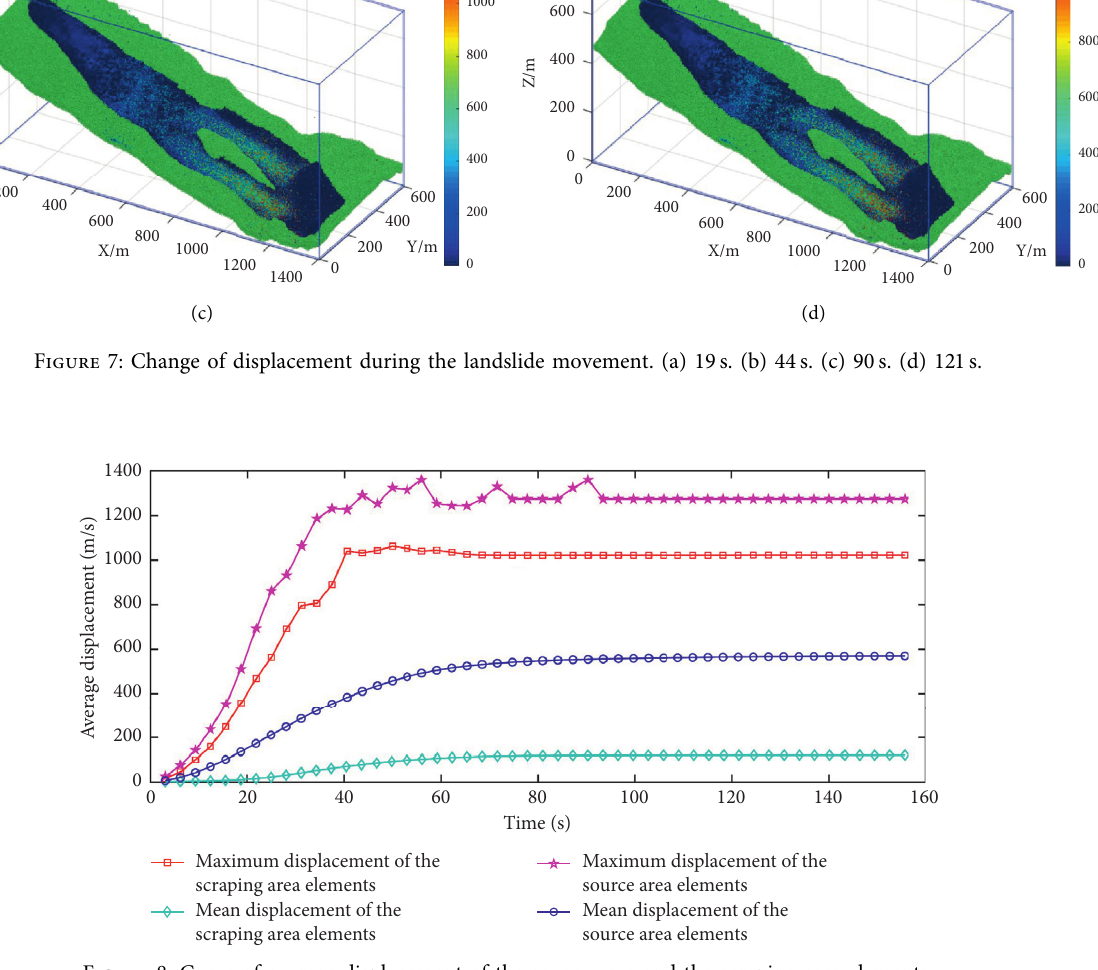
The elements before the scraping area elements' speed of 6.25% All elements of the scraping area